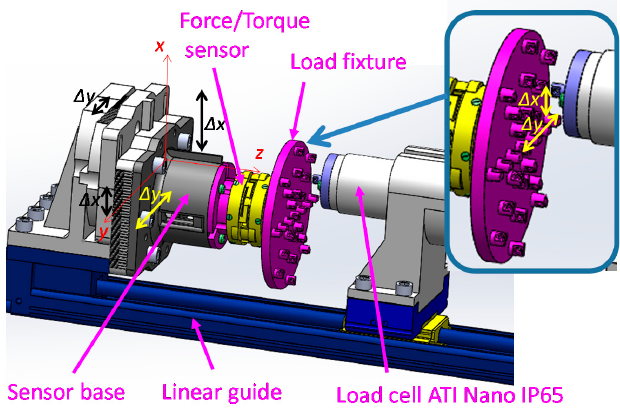
Figure 11. Assembly design of sensor calibration device.